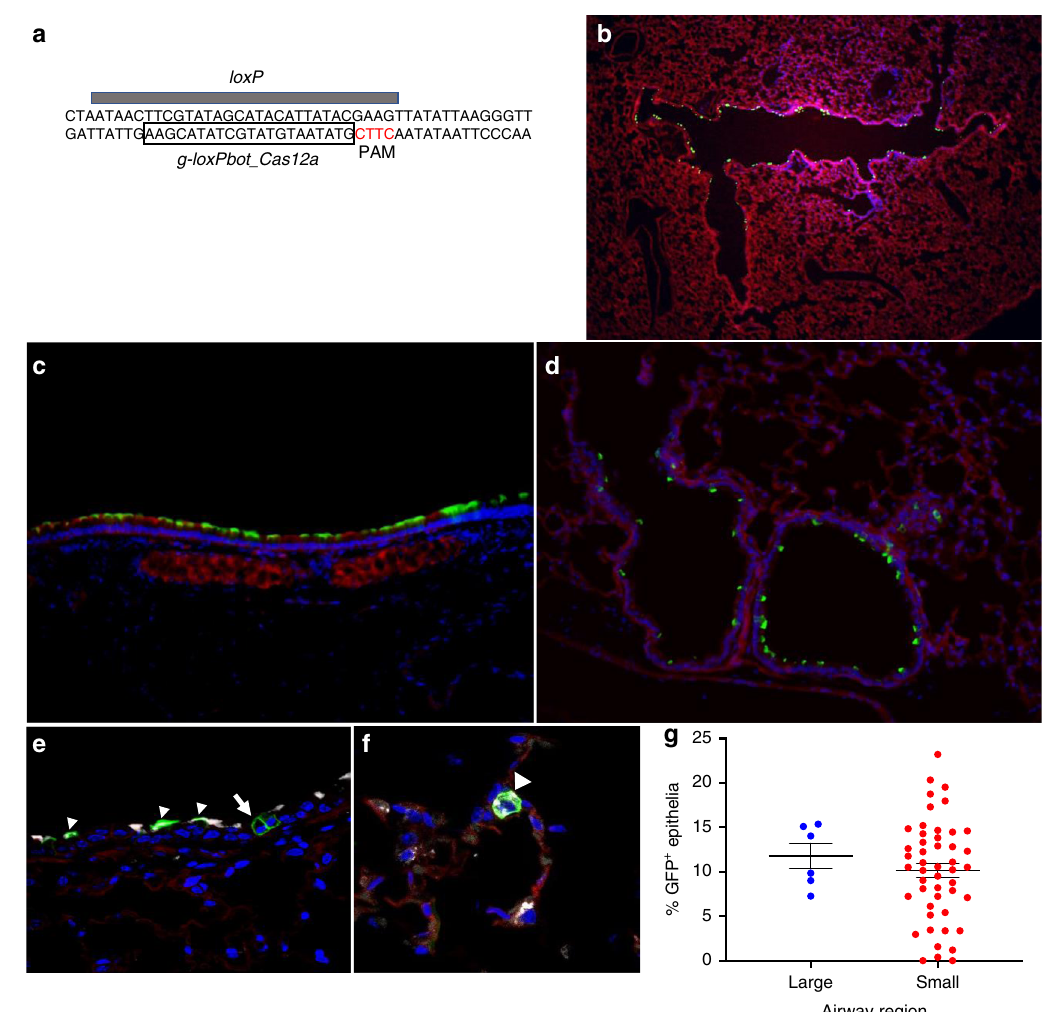
Fig. 6 S10 peptide delivery of Cas12a RNP shows editing in ROSA mT/mG locus in vivo. a Schematic of Cas12a gRNA targeting both loxP sequences fl anking tdTomato gene in ROSA mT/mG mice. S10 peptide and Cas12a RNP (2.5 µ M Cas12a; 2.0 µ M gRNA) directed to suboptimal PAM target in loxP sites fl anking the tdTomato cassette administered twice a day for 2 days, via intranasal instillation. Seven days later, conversion of tdTomato to GFP expression was visualized in lung tissue sections. b Cas12a mediated deletion of tdTomato in ROSA mT/mG in large airway epithelia in vivo; ×2 magni fi cation. c Editing in a large airway; ×20 magni fi cation. d Editing in a small airway; ×20 magni fi cation. e Co-localization of GFP and marker of ciliated cells ( α -tubulin, white)